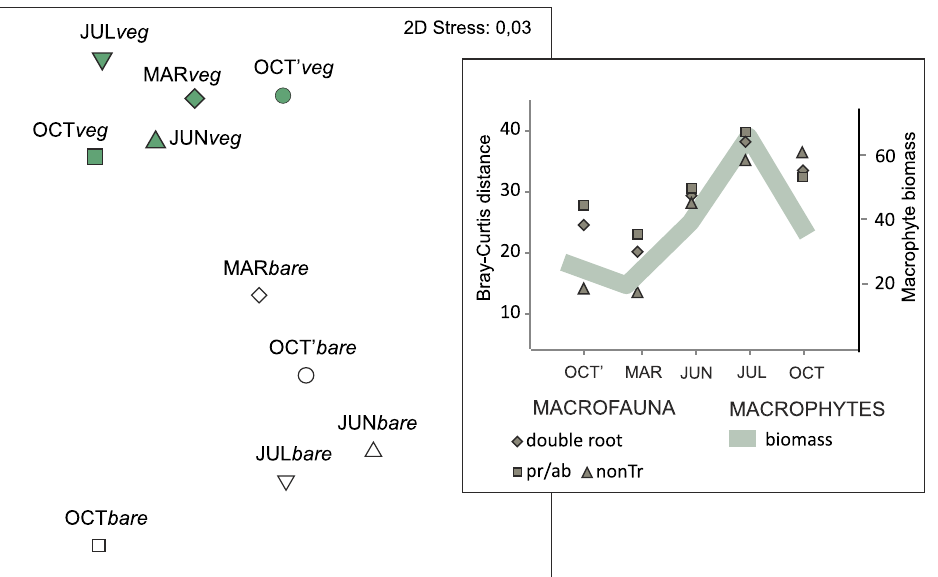
Figure 7. Magnitude of difference in macrofauna community composition between two bottom types in different seasons. nMDS of Bray-Curtis similarities among centroids for groups of samples collected in different months/bottom types ( veg - vegetated bottom, bare - bare sand). Right plot presents Bray-Curtis distances between centroids representing the fauna collected from two bottom types plotted against total macrophyte biomass [g dw m 2 2 ] in 5 months. Macrobenthic dissimilarity calculated based on: presence/absence data (pr/ab), double root transformed, and untransformed data (nonTr).